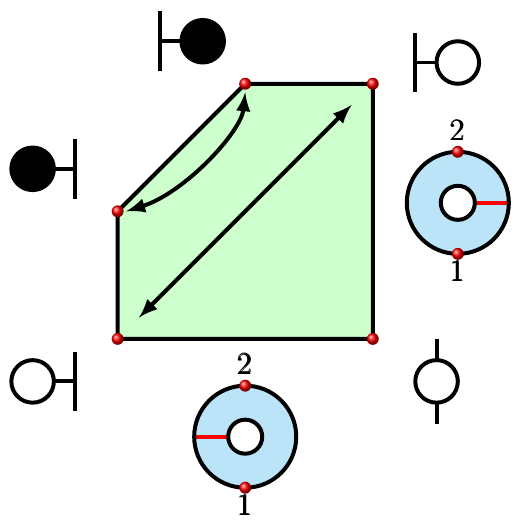
Figure 12 . H 2 is shown with all of its vertices labelled by Feynman diagrams. Note that tadpoles appear in IR-UV pairs (white-black), but also in pairs dictated by the cyclohedron (black arrows). The associahedral facets correspond to the cyclic order (cid:11) = ( (cid:0) 12+) and (cid:11) = ( (cid:0) 21+) in the formula (4.1), but they do not intersect at their tadpole vertices.